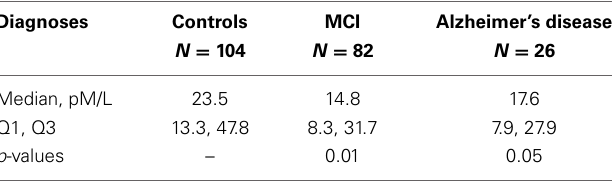
Table 1 | Comparisons of plasma amylin in humans in the absence of diabetes.